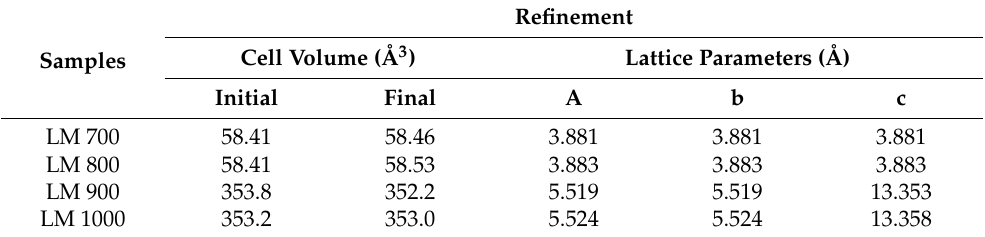
Figure 2. X-ray diffraction patterns of LM 700, LM 800, LM 900, and LM 1000. Table 1. Experimental cell volumes and parameters obtained from Rietveld refinement indicating cubic and rhombohedral phases.